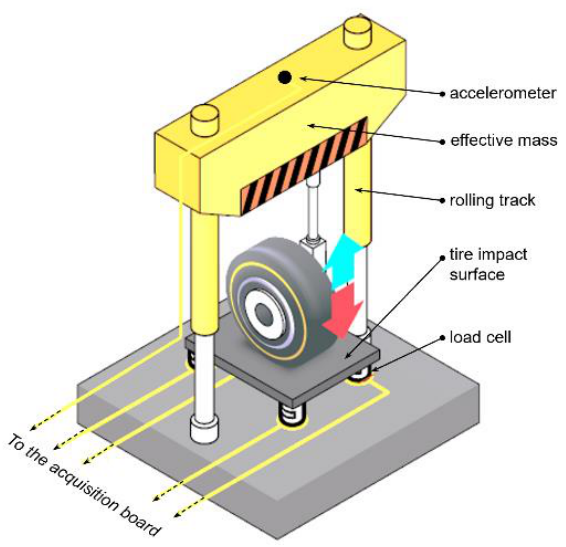
Figure 11. Drop test arrangement (sketch).